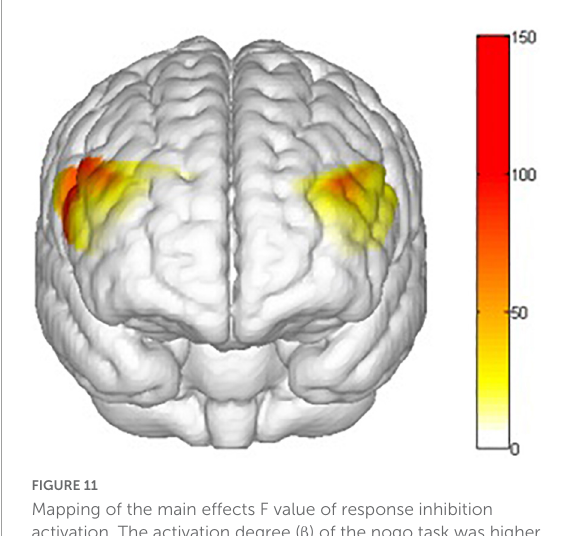
FIGURE13 Main effects t value of training conditions activation by comparing control condition and summer conditions (blank > winter). All statistical parametric maps were created with a threshold of p <